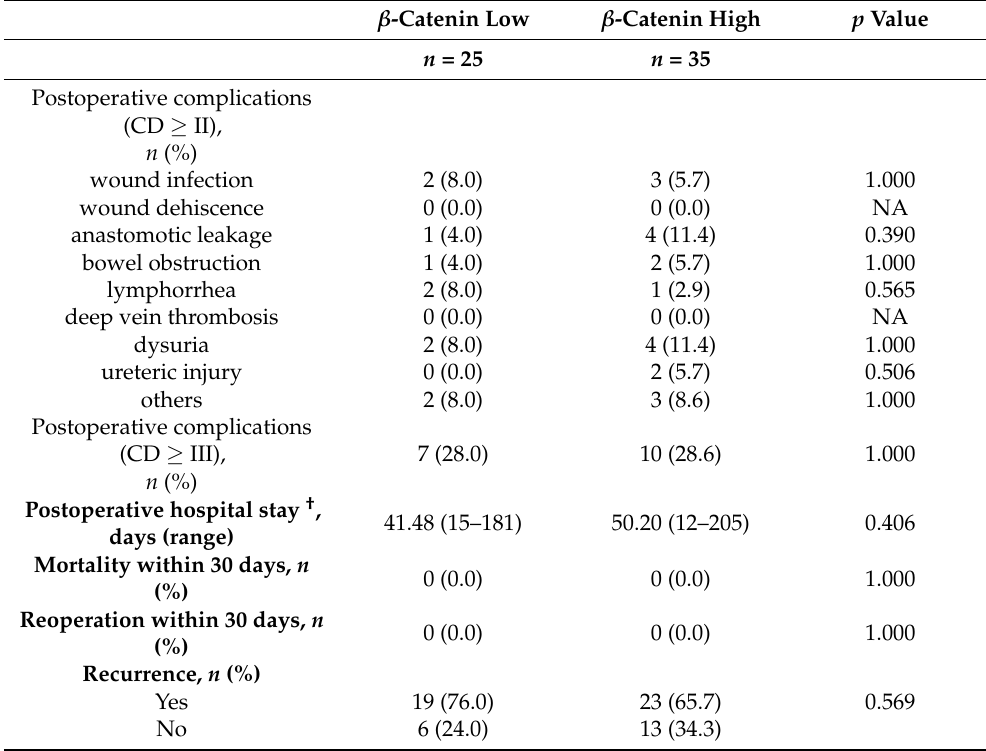
Table 3. Postoperative